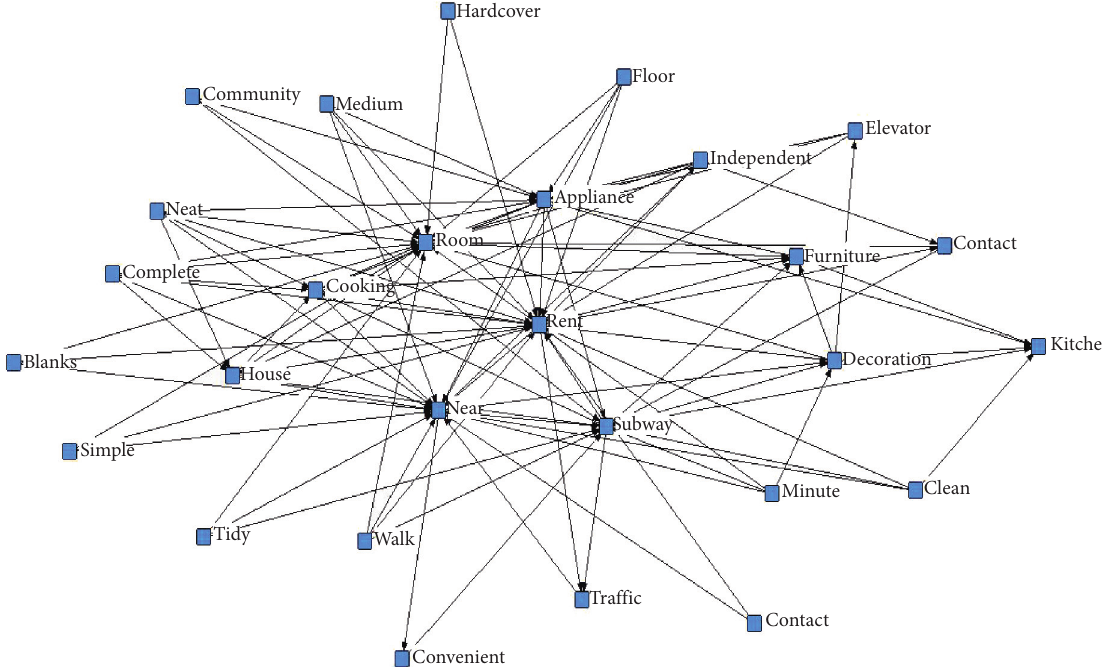
Figure 7: Semantic relationship network map of rent-seeking information.